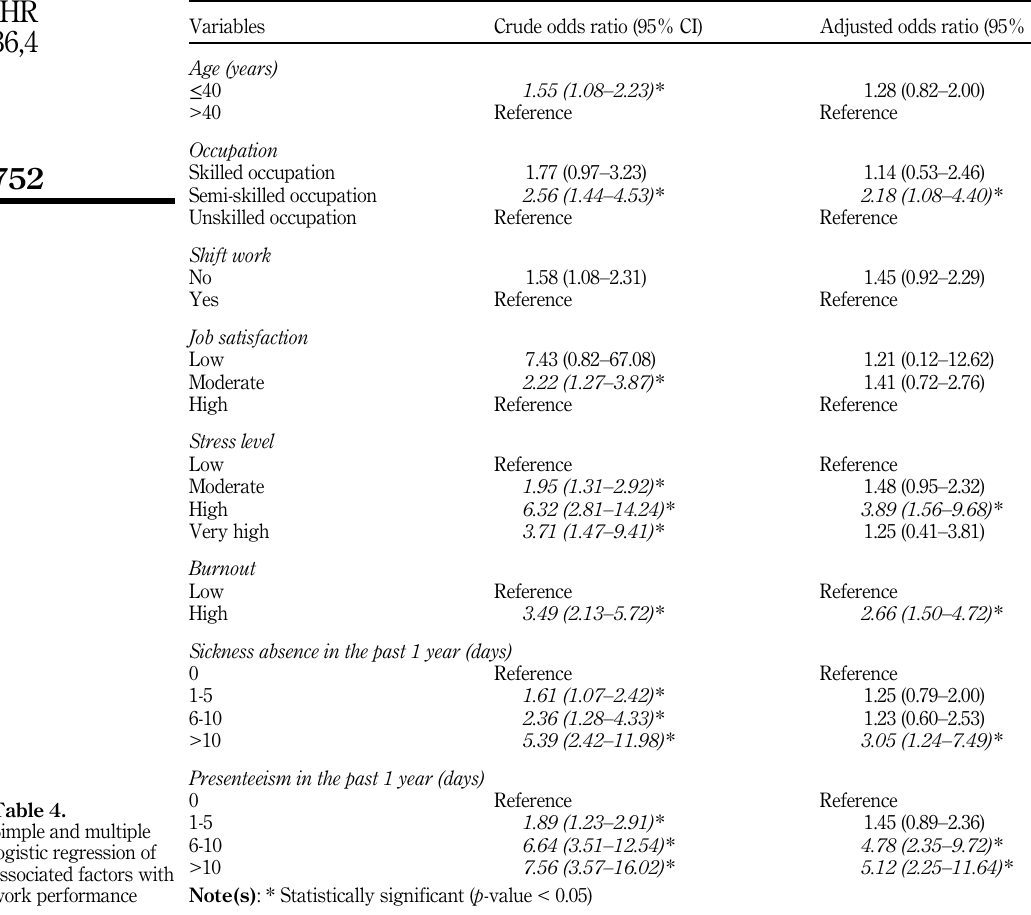
Table 4. Simple and multiple logistic regression of associated factors with work